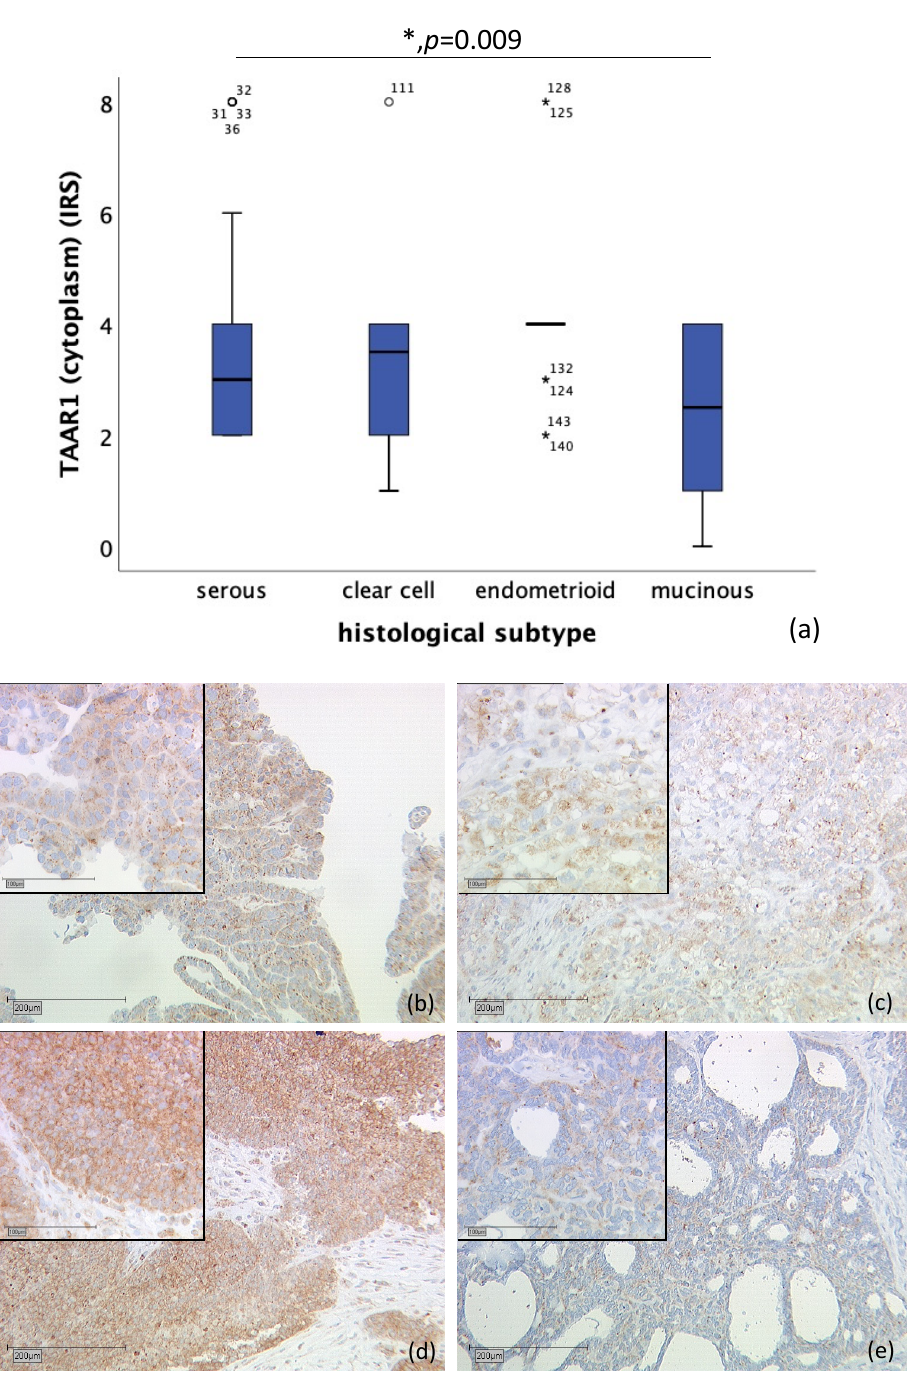
Figure 2. Correlation of cytoplasmic TAAR1 expression with histological subtype ( p = 0.009) ( a ) boxplot of cytoplasmic TAAR1 expression and histological subtype ( b ) serous carcinoma ( n = 89) with a cytoplasmic TAAR1 IRS of 3, magnification ×10 and ×25 in the inset ( c ) clear cell carcinoma ( n = 10) with a cytoplasmic TAAR1 IRS of 3, magnification ×10 and ×25 in the inset ( d ) endometrioid carcinoma ( n = 19) with a cytoplasmic TAAR1 IRS of 4, magnification ×10 and ×25 in the inset ( e ) mucinous carcinoma ( n = 10) with a cytoplasmic TAAR1 IRS of 2, magnification ×10 and ×25 in the inset; * p < 0.05 was considered statistically significant.